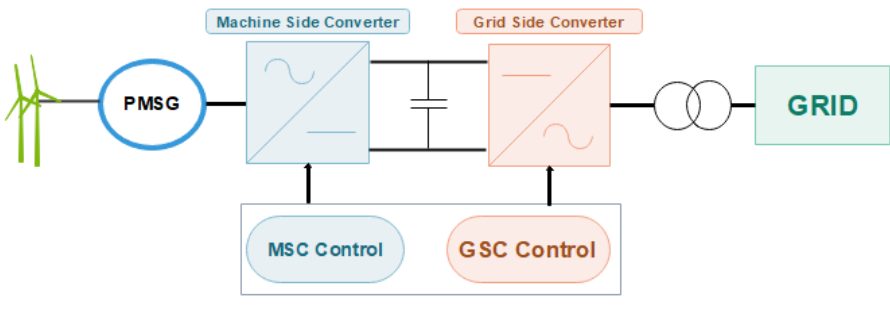
Figure 6. Grid-connected PMSG WECS.